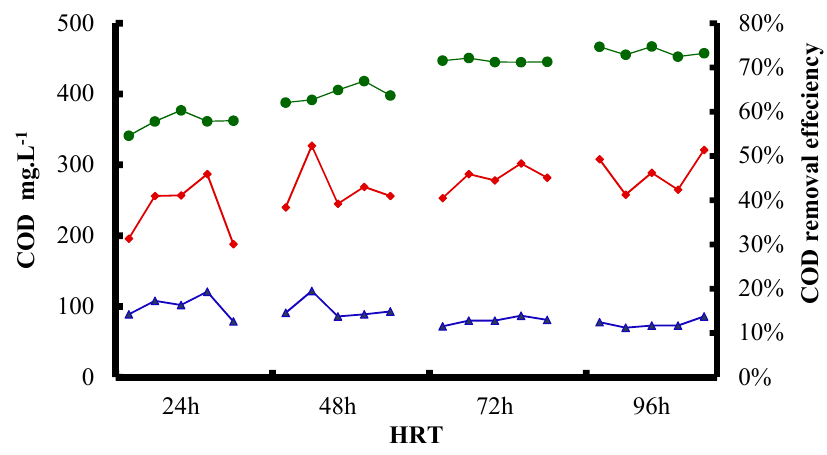
Figure 2. COD concentration and removal efficiency of ABR under different HRTs. Influent water; Effluent water; COD removal efficiency.